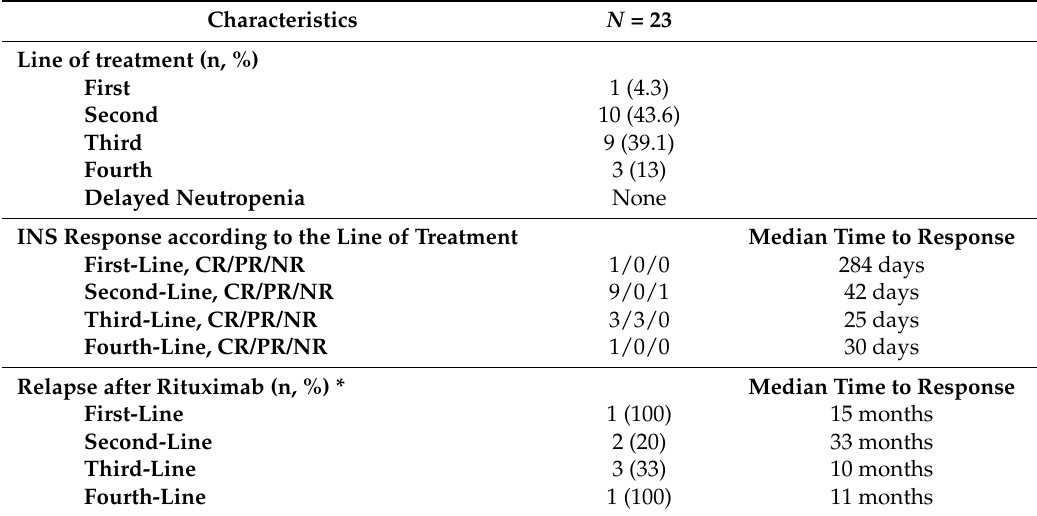
Table 3. Outcomes of 23 older patients with INS receiving a monoclonal anti-CD20 antibody. CR, complete response; PR, partial response; NR, no response. * Relapse occurred after a median time of 13 months (10–23) following the use of rituximab.